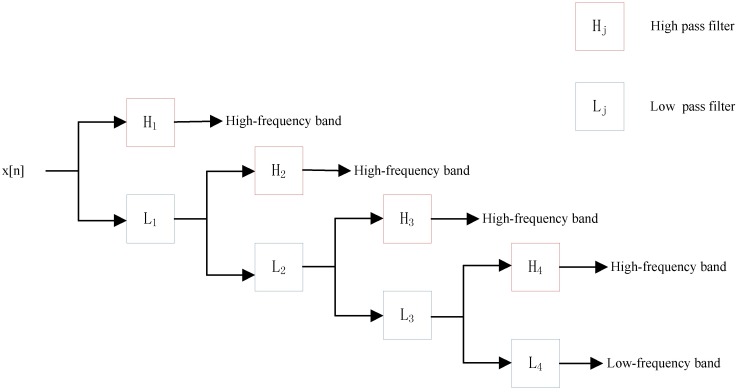
Schematic diagram of a 4-level DWT.